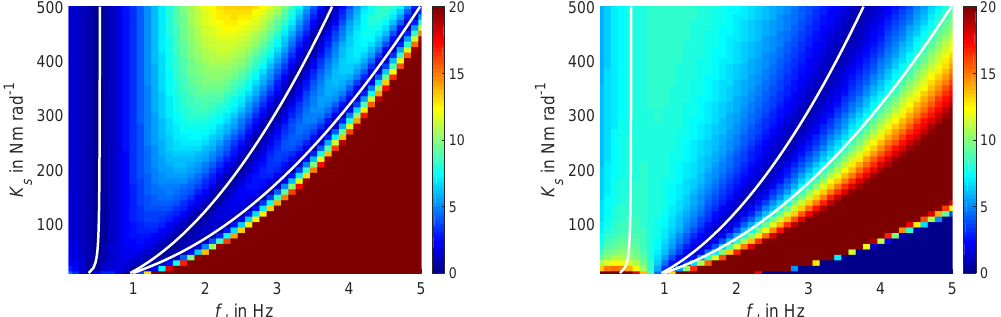
Figure 2. Consumed Energy per Oscillation in J of the ideal system ( left ) and considering friction ( right ).